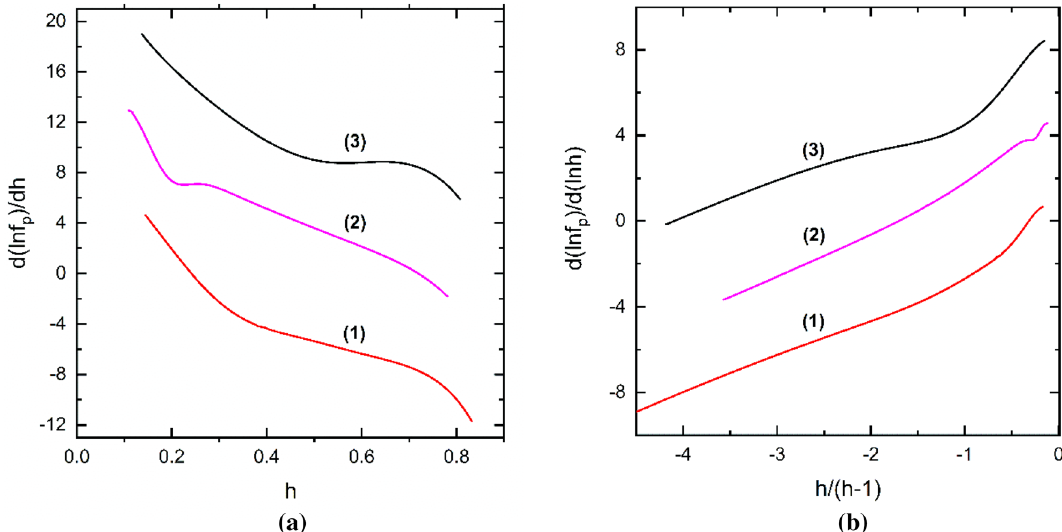
Figure 5. The dependence of the derivative of the fit functions of f p with Eq. (6) at T = 15 K. The curves are for: (1) ( i ) pure MgB 2 ; (2) ( ii ) (MgB 2 ) 0.99 (Te 0.25 (HoO 1.5 ) 0.75 ) 0.01 ; (3) ( iii ) (MgB 2 ) 0.99 (B 4 C) 0.01 . Panel ( a ) shows d ( ln f p ) h -dependence of logarithmic derivative of f p , dh . The plots (2) and (3) are shifted upward with 8 and 16 units, d ( ln f p ) respectively. Panel ( b ) presents dependence of d ( ln h ) vs. x = h /( h − 1). The plots (2) and (3) are shifted upward with 4 and 8 units,